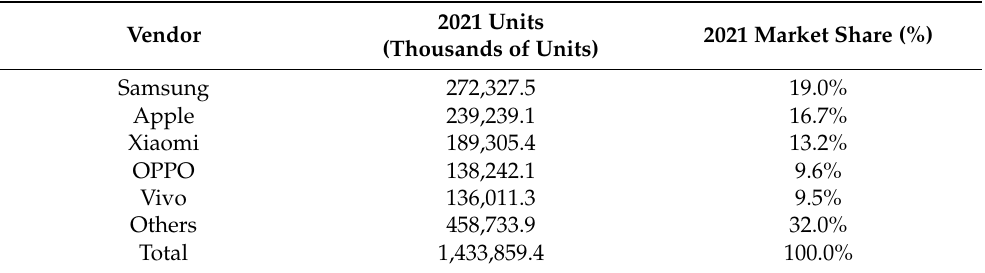
Table 2. Worldwide smartphone sales to end users by vendor in 2021 (Gartner, March 2022 [16]).